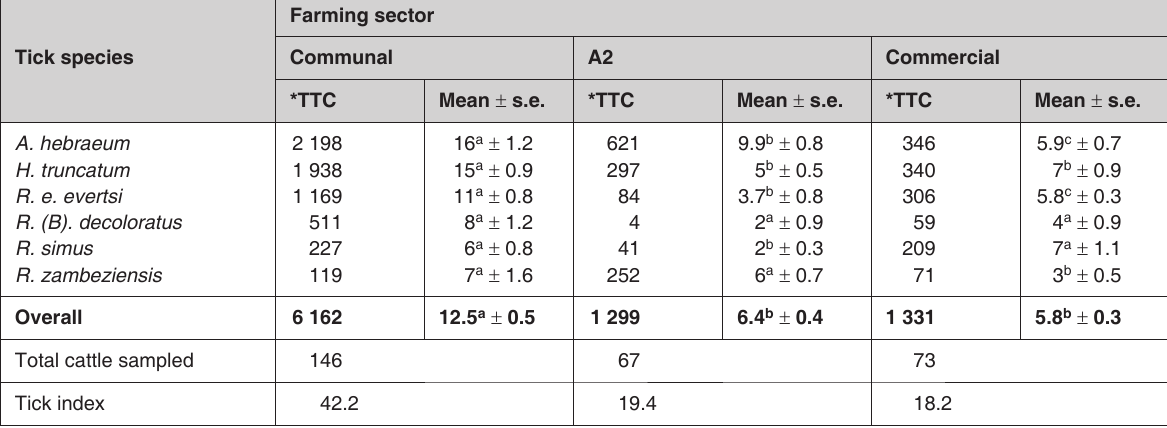
TABLE 3 Total tick counts, mean tick counts and tick index according to farming sector and tick species identified by visual